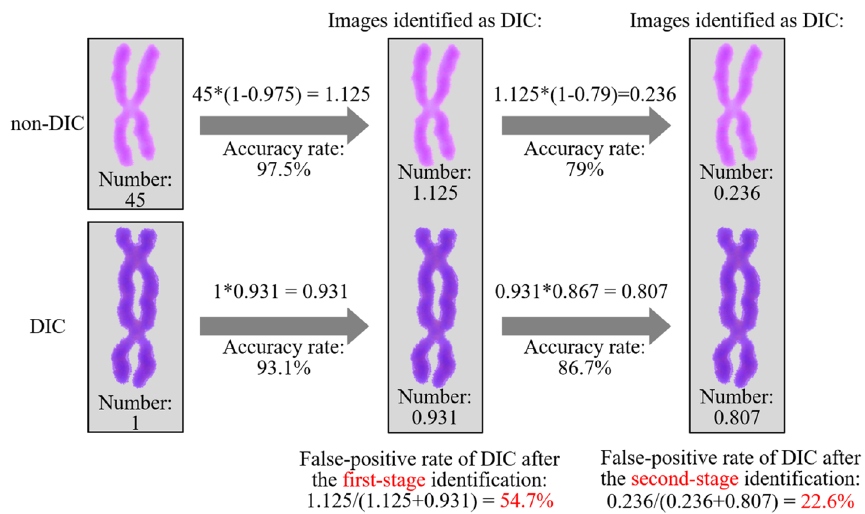
Figure 11. False positive rate of DIC identified by identification method using two-stage